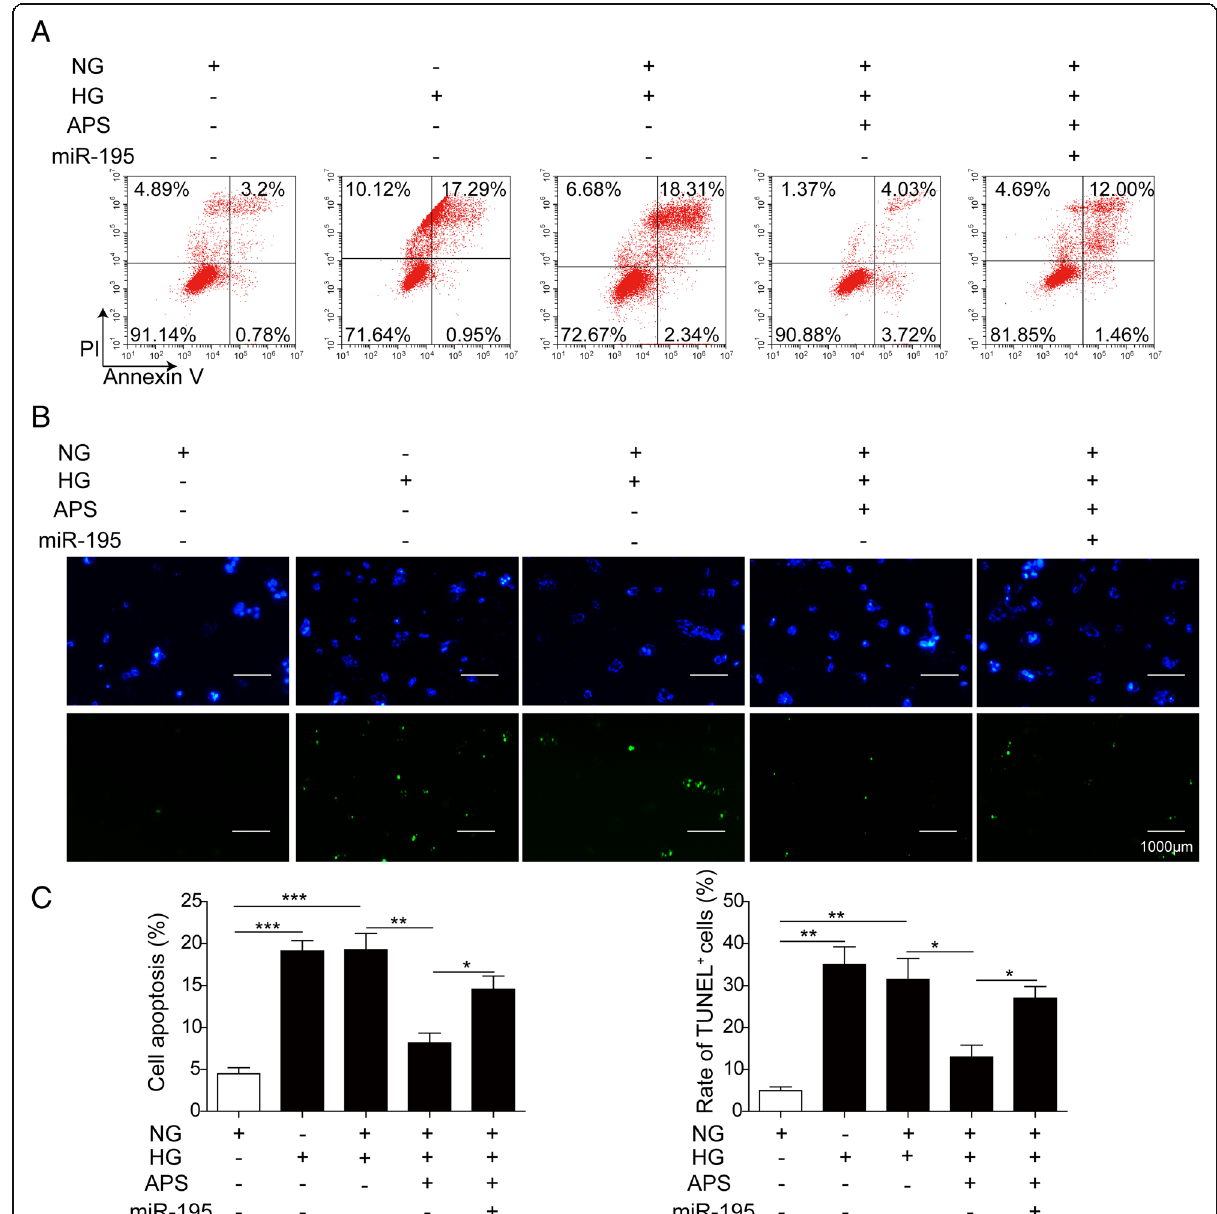
Fig. 10 Overexpression of miR-195 enhanced the cell apoptosis in ARPE-19 cells. a Flow cytometry showed miR-195 increased the cell apoptosis compared to the APS treated ARPE-19 cells. b TUNEL staining showed miR-195 increased the TUNEL positive cells compared to the APS treated ARPE-19 cells. c The statistical results of flow cytometry and TUNEL staining in A and B. Error bars represented mean ± SD. *** p < 0.001, ** p < 0.01, * p <